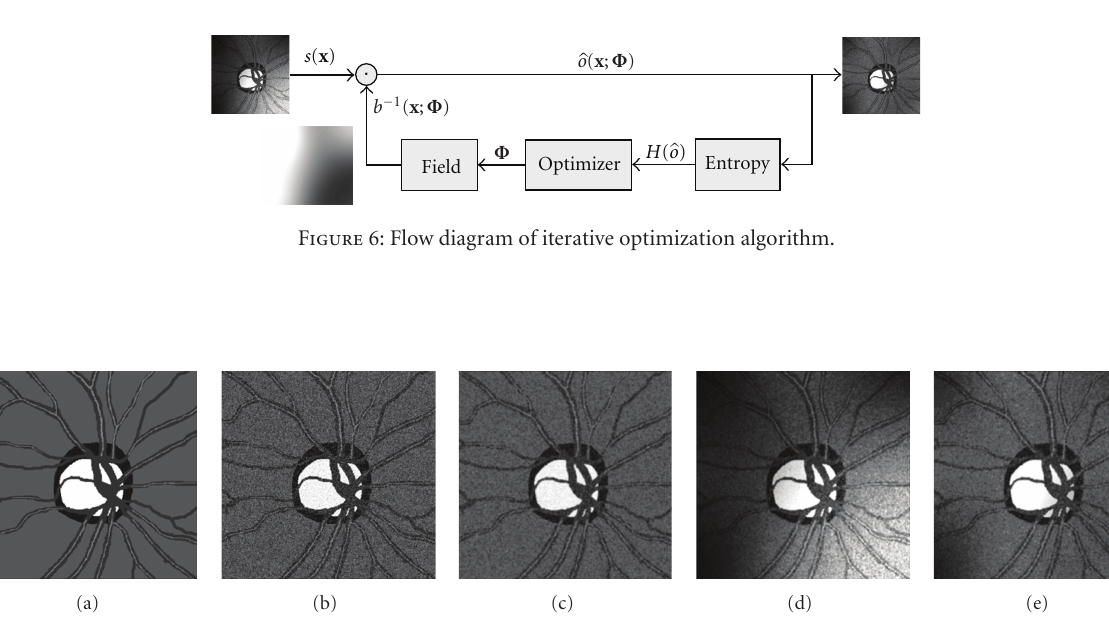
Figure 7: (a): Ideal model image created by manual segmentation of a real image, (b): Model image after noise addition, (c): Model image after noise addition and convolution with PSF of the imaging system. (d): Final model image corrupted by non-homogenous illumination. (e): the image after processing by the presented